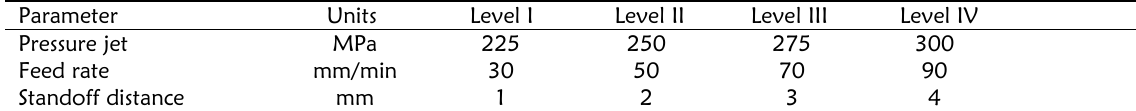
Table 4: Process control parameters and levels